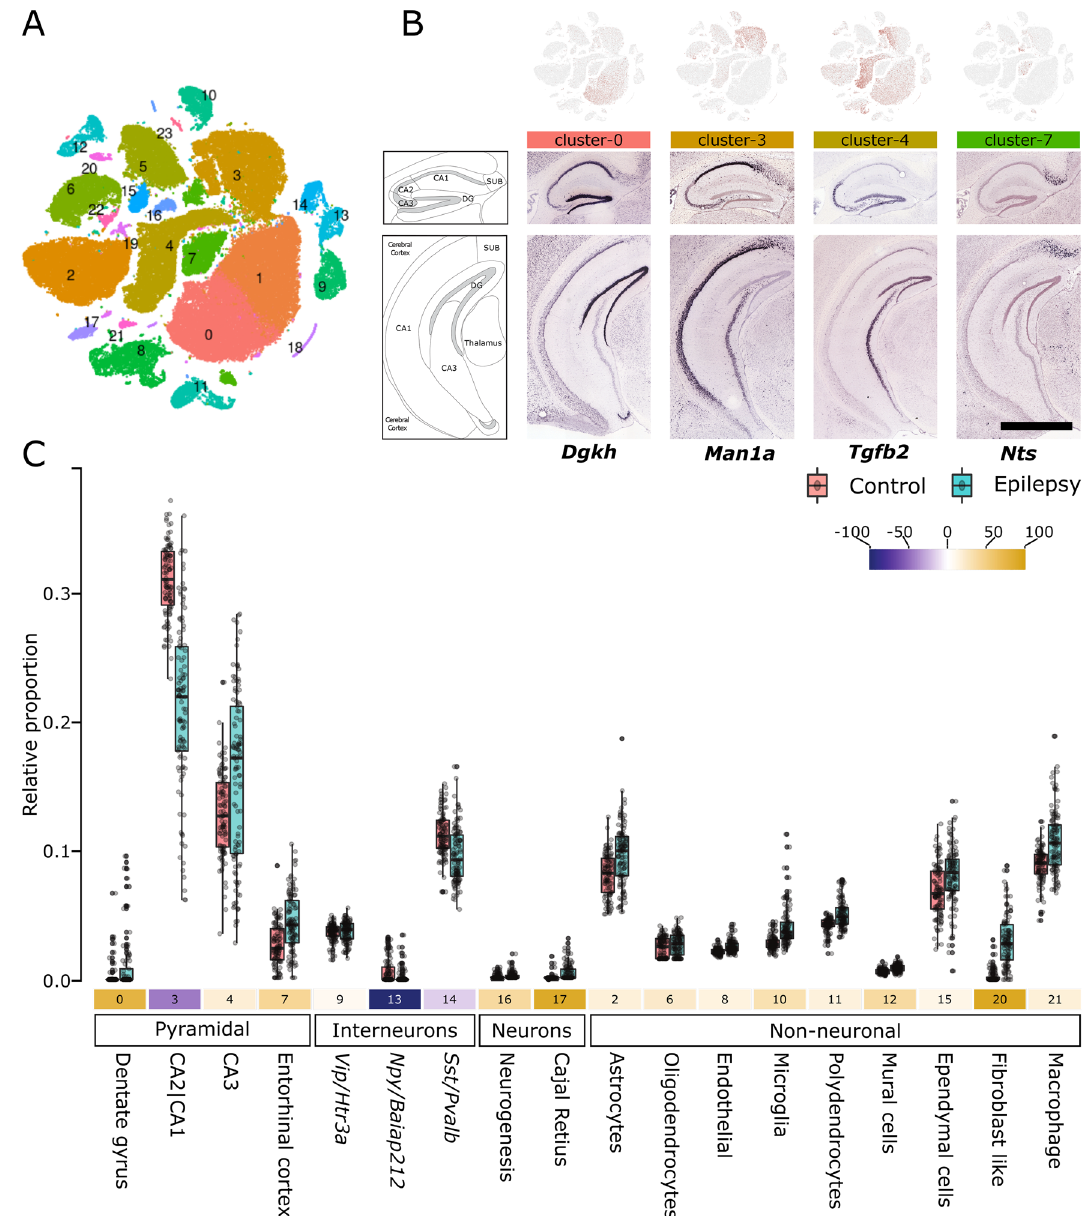
Figure 2. Cell-type deconvolution of TLE RNAseq data reveals altered neuronal and non-neuronal cell proportions. ( A ) Clustering of mouse hippocampus single-cell RNAseq data from Gene Expression Omnibus (GSE116470). See Figure S1 for cluster characterization and Table S4 for cluster-specific genes. ( B ) Cell-type clusters representing pyramidal neurons were enriched in different hippocampal regions and subfields. In situ hybridization data (Allen brain atlas) of genes (discrete markers, Table S4) representative of the pyramidal- neuron-specific cluster-0 (Dgkh), cluster-3 (Man1a), cluster-4 (Tgfb2), and cluster-7 (Nts) are shown. Scale bar, 1678 micron. ( C ) Proportional differences of cell-type clusters in the control and epileptic cohorts. The Y-axis shows the relative proportion of different cell-type clusters. The number below each box plot represents the cluster number from ( A ), and the colors in shades of blue and yellow indicate a decrease or increase in the percentage of relative cell proportions, respectively. All changes in proportions were significant (P < 0.001; Wilcoxon test). See Table S4for additional